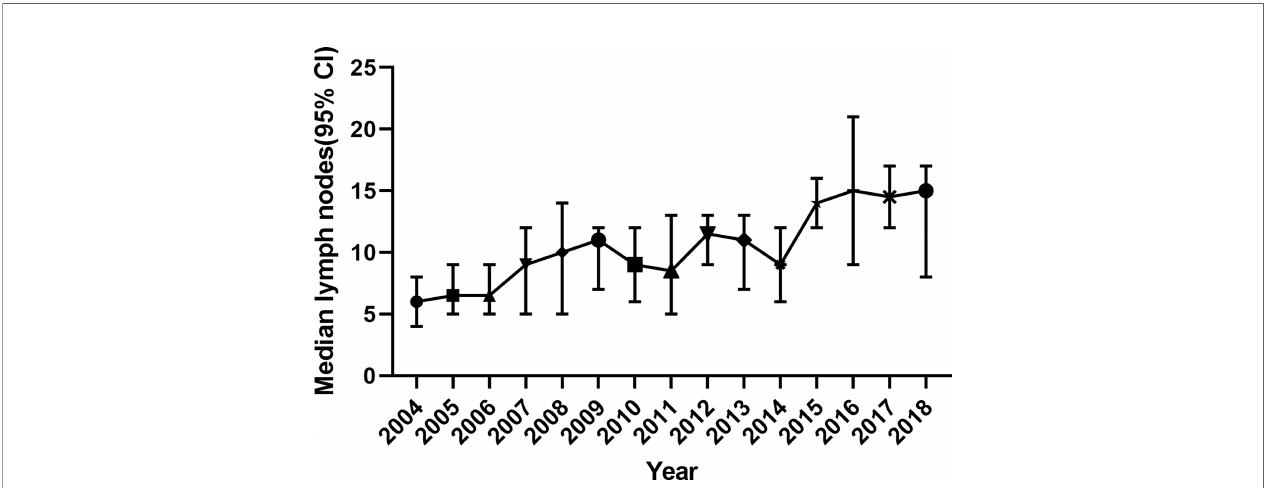
FIGURE 5 | The number of surgically removed lymph nodes in stage II SBA patients from 2004 to 2018, indicated by median and 95% CI. SBA, small bowel